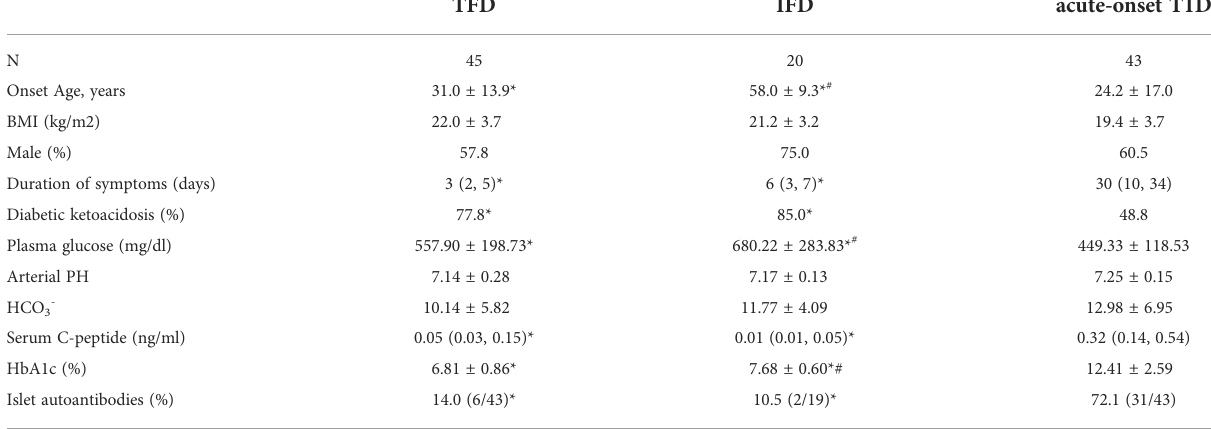
TABLE 5 Comparison of the clinical and biological characteristics among IFD, TFD, and acute-onset T1D in Chinese